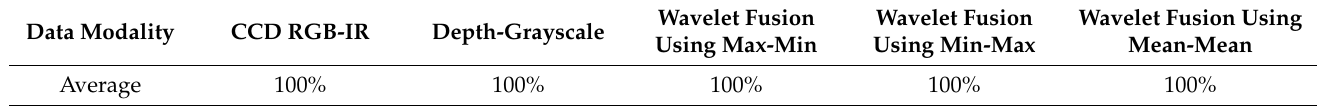
Table 2. Recognition performances of hand gesture intention recognition by typical deep learning of a VGG-16 CNN with only a single modality of CCD RGB-IR or depth-grayscale images and the proposed VGG-16 CNN deep learning with wavelet image fusion of CCD RGB-IR and depth- grayscale by “max-min”, “min-max” or “mean-mean” merge types on recognition system training.